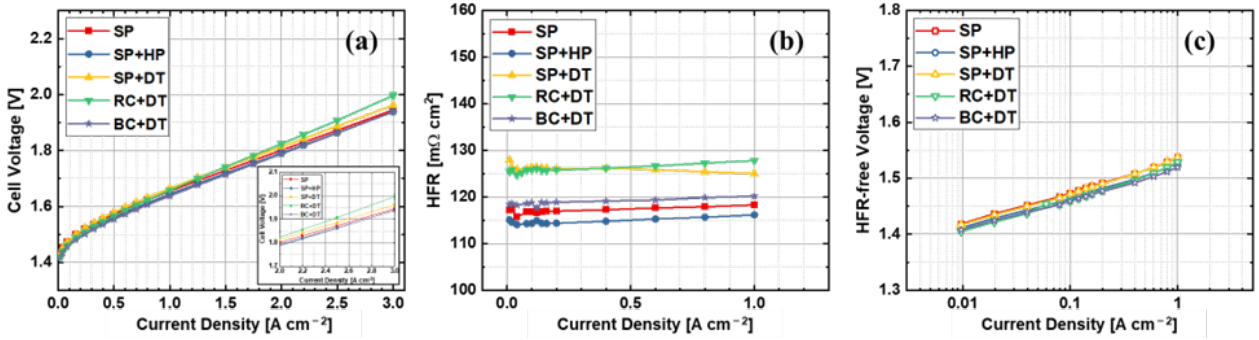
Figure 3. Results comparison between various anode electrode fabrication methods. ( a ) Performance, ( b ) HFR, ( c ) Tafel slopes.